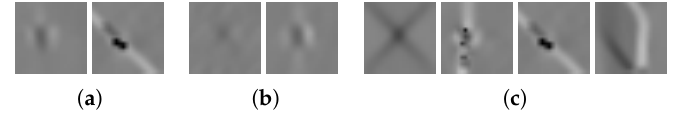
Figure 18. ( a ) Star cracks predicted as comets by SVM + conv3 (CNN 20), ( b ) star cracks predicted as grinding groove regions by SVM + 19 Features, ( c ) one star crack predicted as background region, two star cracks predicted as comets, and one star crack predicted as grinding groove region by CNN 20.